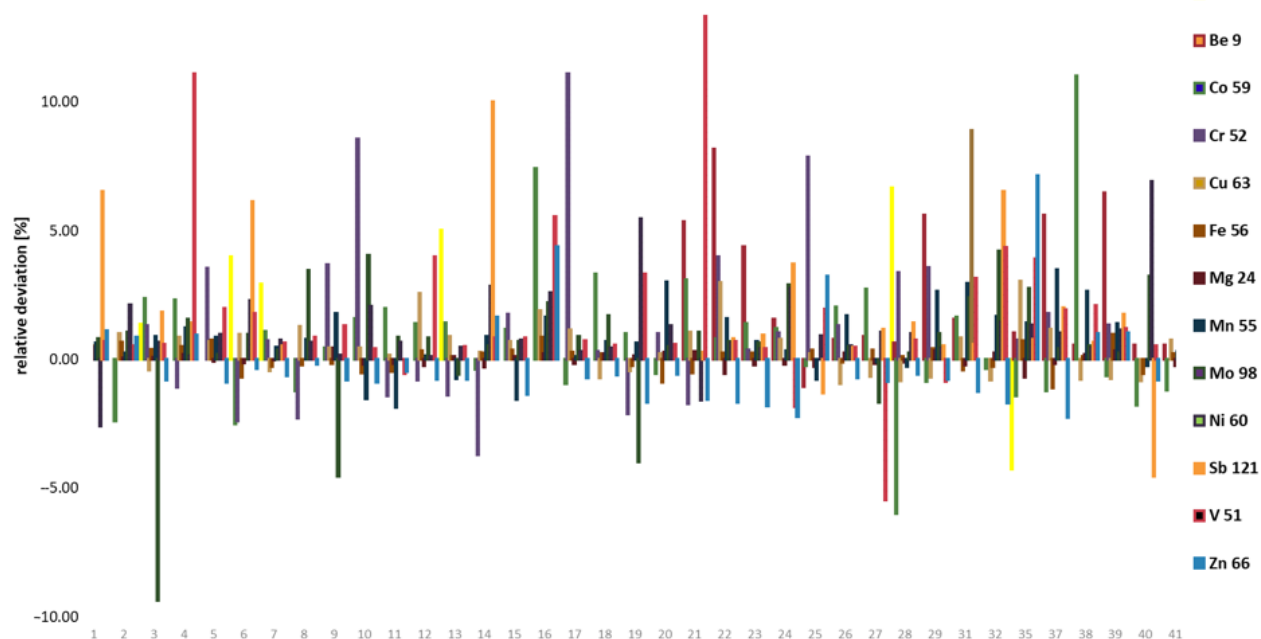
Figure 2. Comparison of sample preparation protocols for all honey Figure 2 . Comparison of sample preparation protocols for all honey samples.